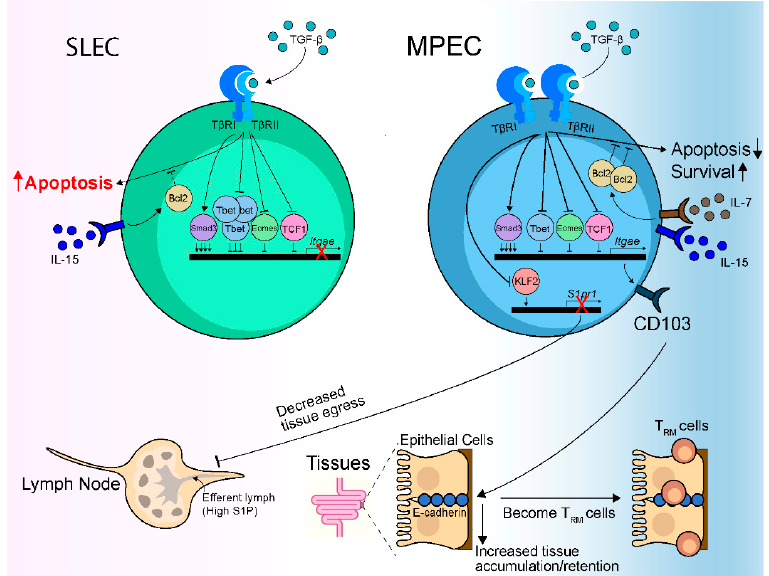
Figure 2. TGF- β regulates the development and maintenance of CD103 + CD8 T RM cells through multiple mechanisms. (1) By skewing towards an MPEC phenotype—MPEC, but not SLEC, can